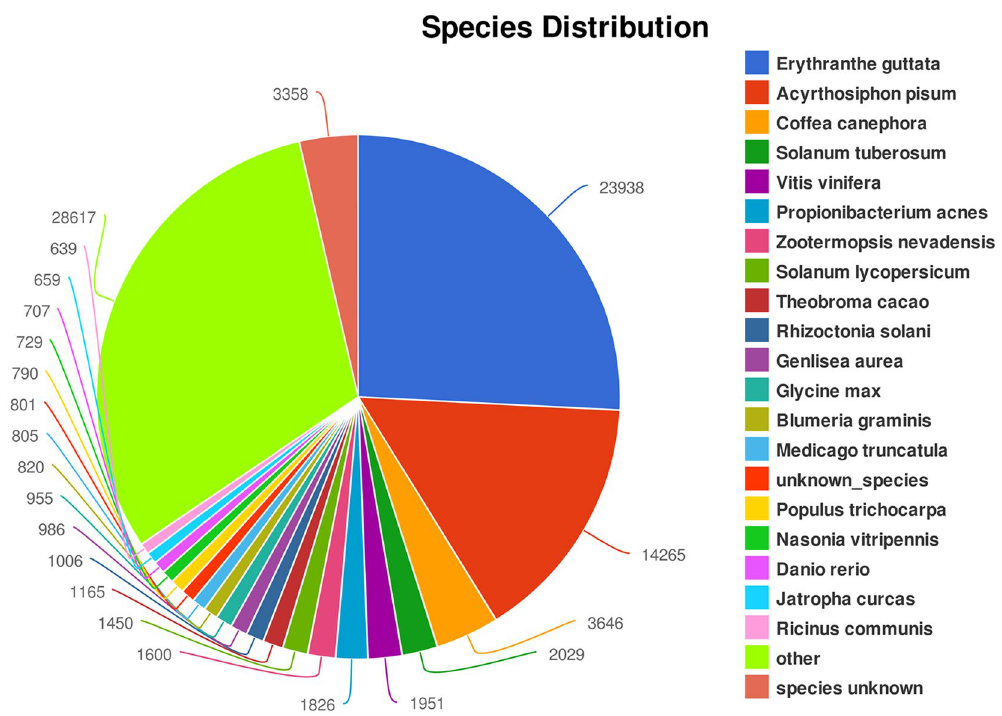
Figure 2. Global transcripts similarity of D. tanguticum abundant transcriptome to those of other plant